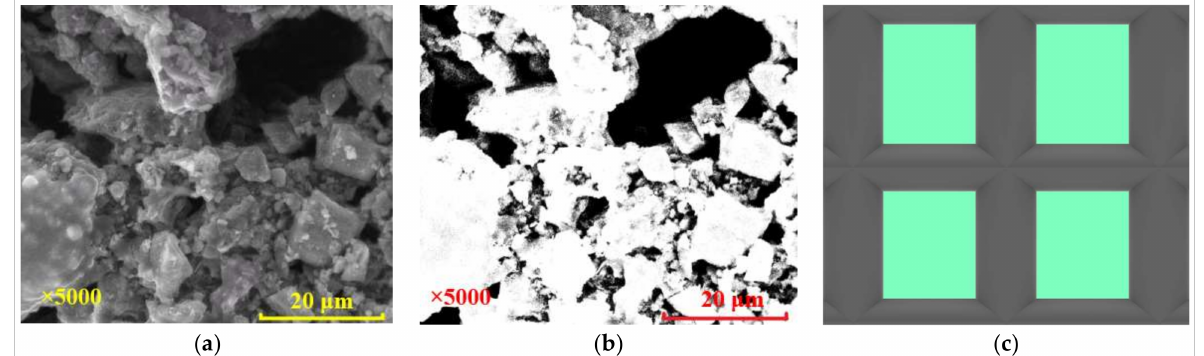
Figure 12. Binary analysis of a microscopic image of the paste without pumping agent and the extraction process of the force chain: ( a ) SEM image at a magnification of 5000; ( b ) binary image; ( c ) idealized sketch of force chain.